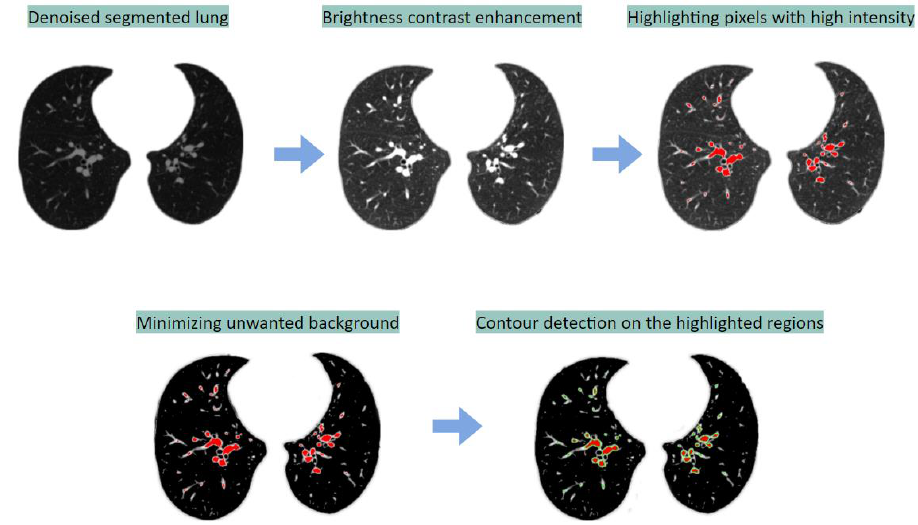
Figure 24. Sample outputs of clustering approach.